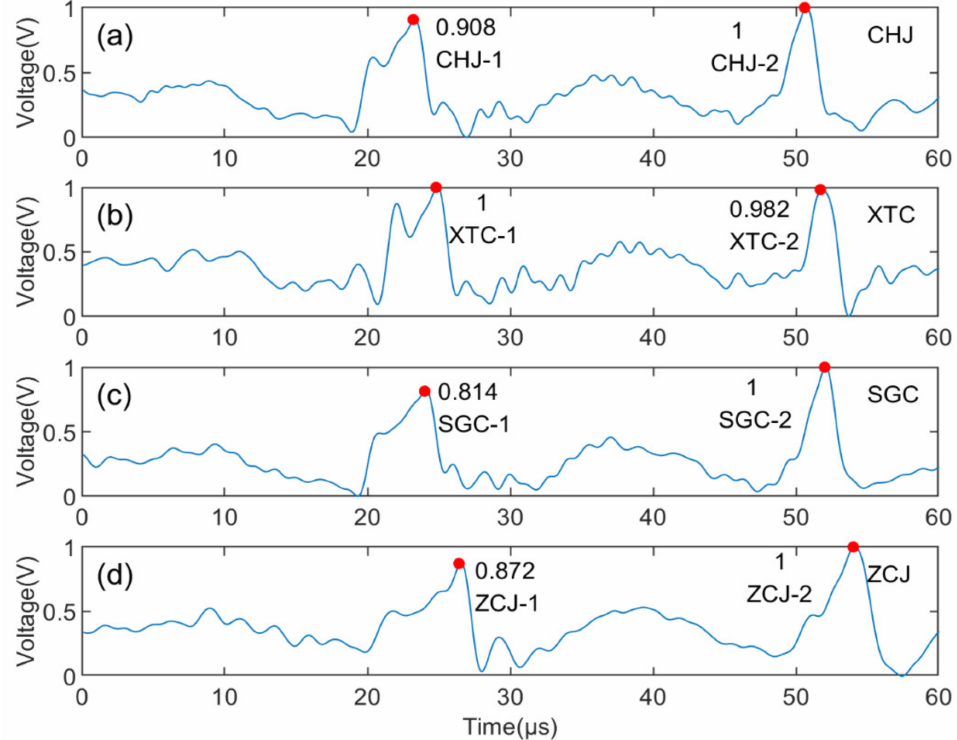
Figure 5. The synchronous electric field waveforms of CHJ ( a ), XTC ( b ), SGC ( c ) and ZCJ ( d ) observed by LFEDA at 16:26:00 on 15 August 2015 (Beijing time) The red dot represents the position of the identified pulse peak, and the number represents the specific value of the pulse peak. The two large pulse signals of each station are represented by station name-1 and station